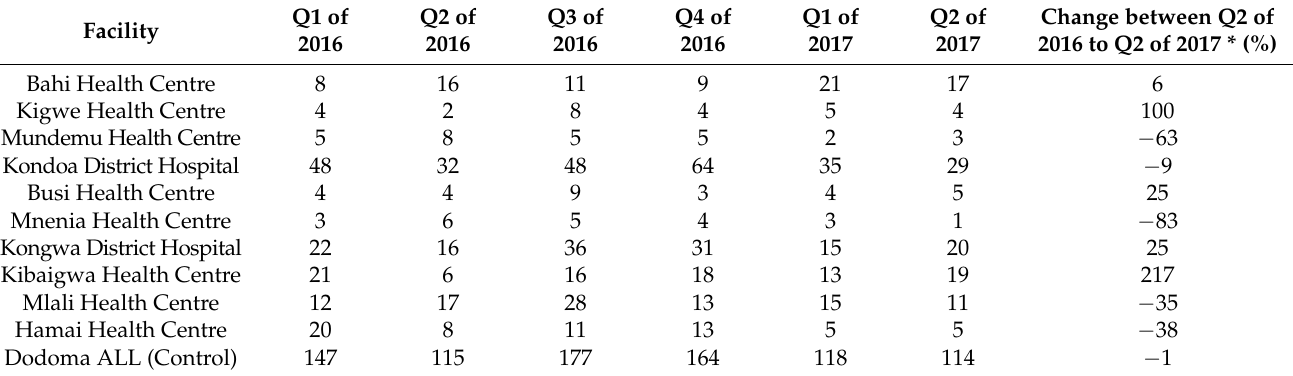
Table 2. Quarterly TB case notification in 10 control facilities in Dodoma (Q1 of 2016–Q2 of 2017),